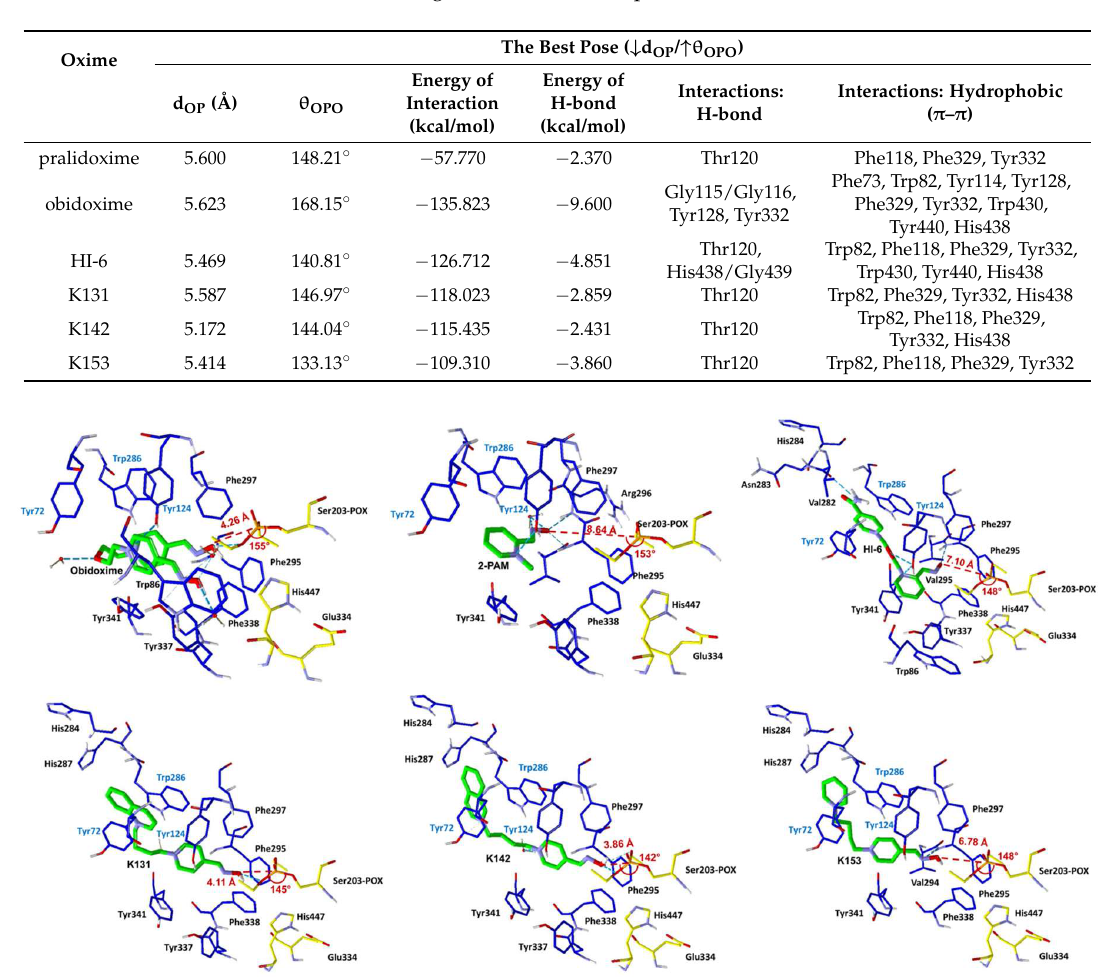
Figure 5. Best poses of the oximes inside the complex Hss BChE/POX. Distances P OP − O Ser203 and angles O ox − P OP − O Ser203 are shown in red.